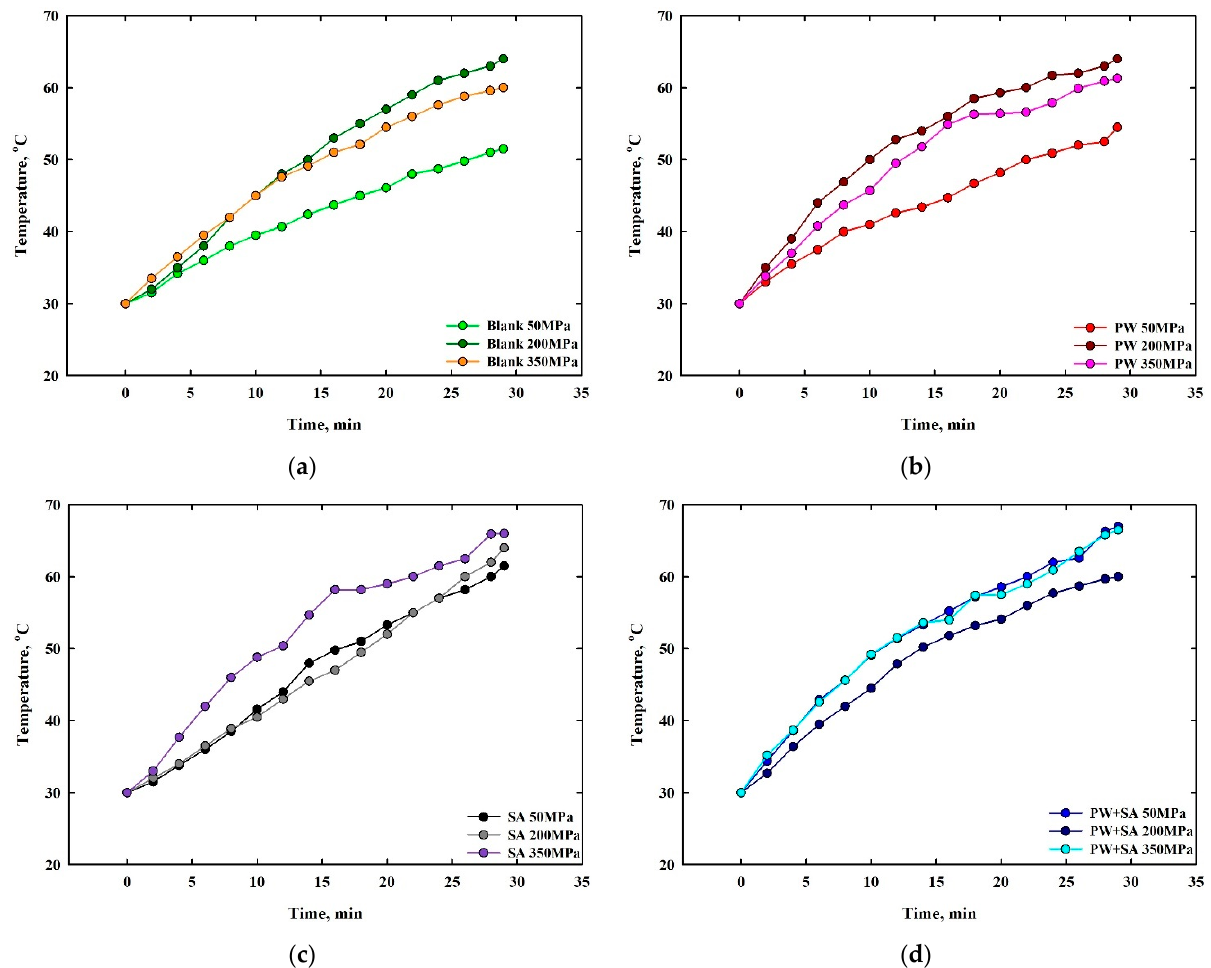
Figure 12. Friction temperature gains as a function of sliding distance for sintered Cu–15Fe-based com- posite samples: ( a ) blank, ( b ) PW, ( c ) SA, and ( d ) PW+SA, under different compaction pressure levels.